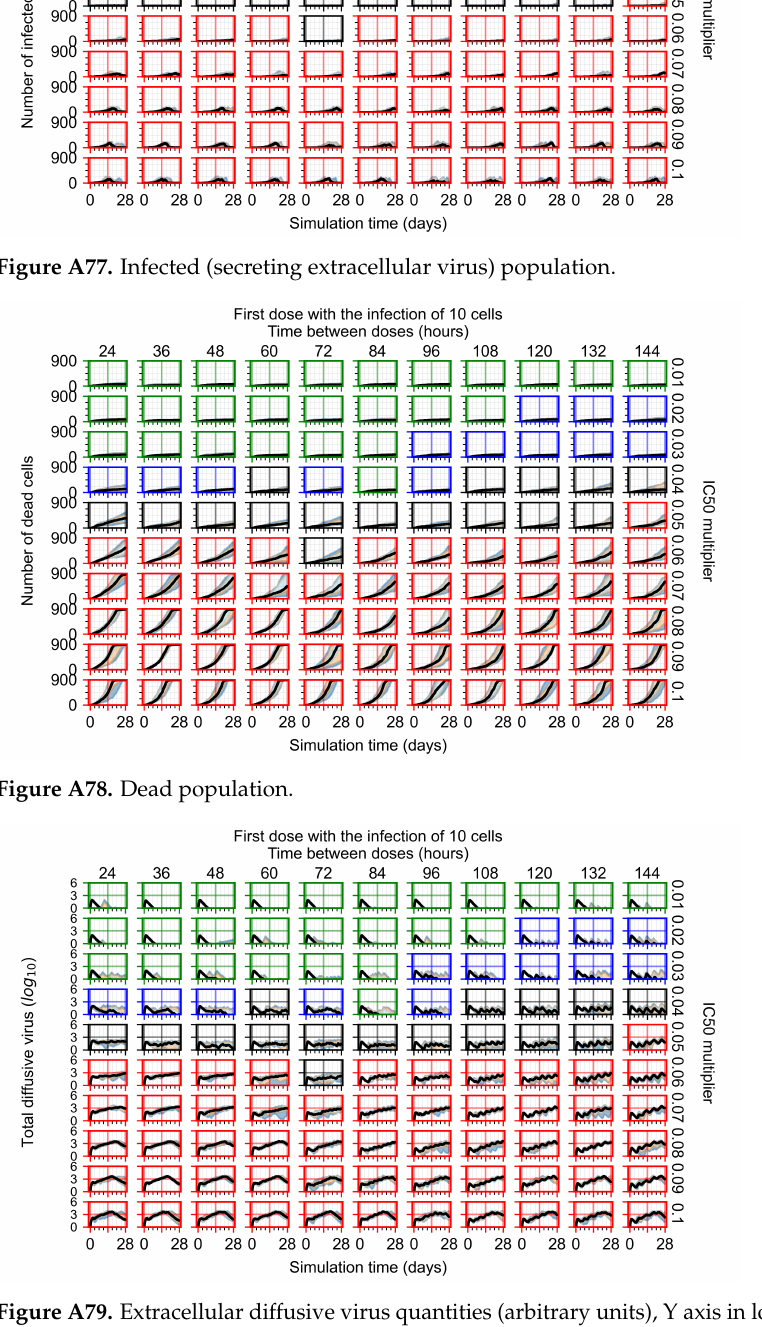
Figure A79. Extracellular diffusive virus quantities (arbitrary units), Y axis in log scale, and exponent values as tick